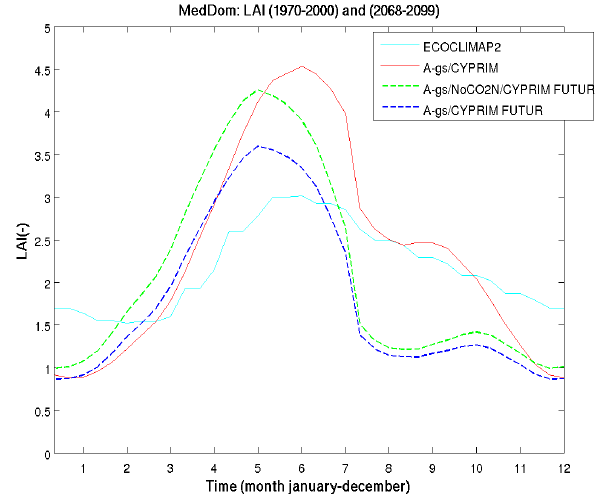
Figure 3: Mean annual cycle of LAI for the Mediterranean Domain (MedDom), averaged over 3 Fig. 3. Mean annual cycle of LAI for the Mediterranean Do- main (MedDom), averaged over 1970–2000 for the ECOCLIMAP2 1970-2000 for the ECOCLIMAP2 database and for ISBA-A-gs with CYPRIM climate 4 database and for ISBA-A-gs with CYPRIM climate scenario scenario (A-gs/CYPRIM), and averaged over 2069-2099 for ISBA-A-gs with CYPRIM 5 (A-gs/CYPRIM), and averaged over 2069–2099 for ISBA-A-gs scenario (A-gs/CYPRIM FUTUR) and for ISBA-A-gs/NoCO2N with CYPRIM scenario (A-6 with CYPRIM scenario (A-gs/CYPRIM FUTUR) and for ISBA- gs/NoCO2N/CYPRIM FUTUR). 7 A-gs/NoCO2N with CYPRIM scenario (A-gs/NoCO2N/CYPRIM